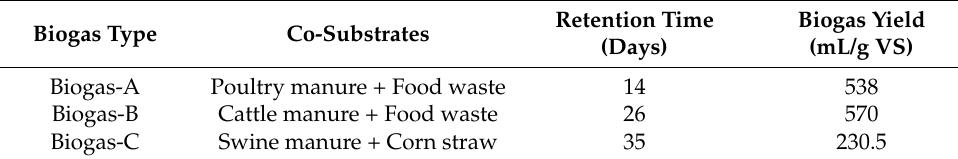
Figure 1. Proposed biogas powered multigeneration system. Table 1. Biogas production results from the co-digestion